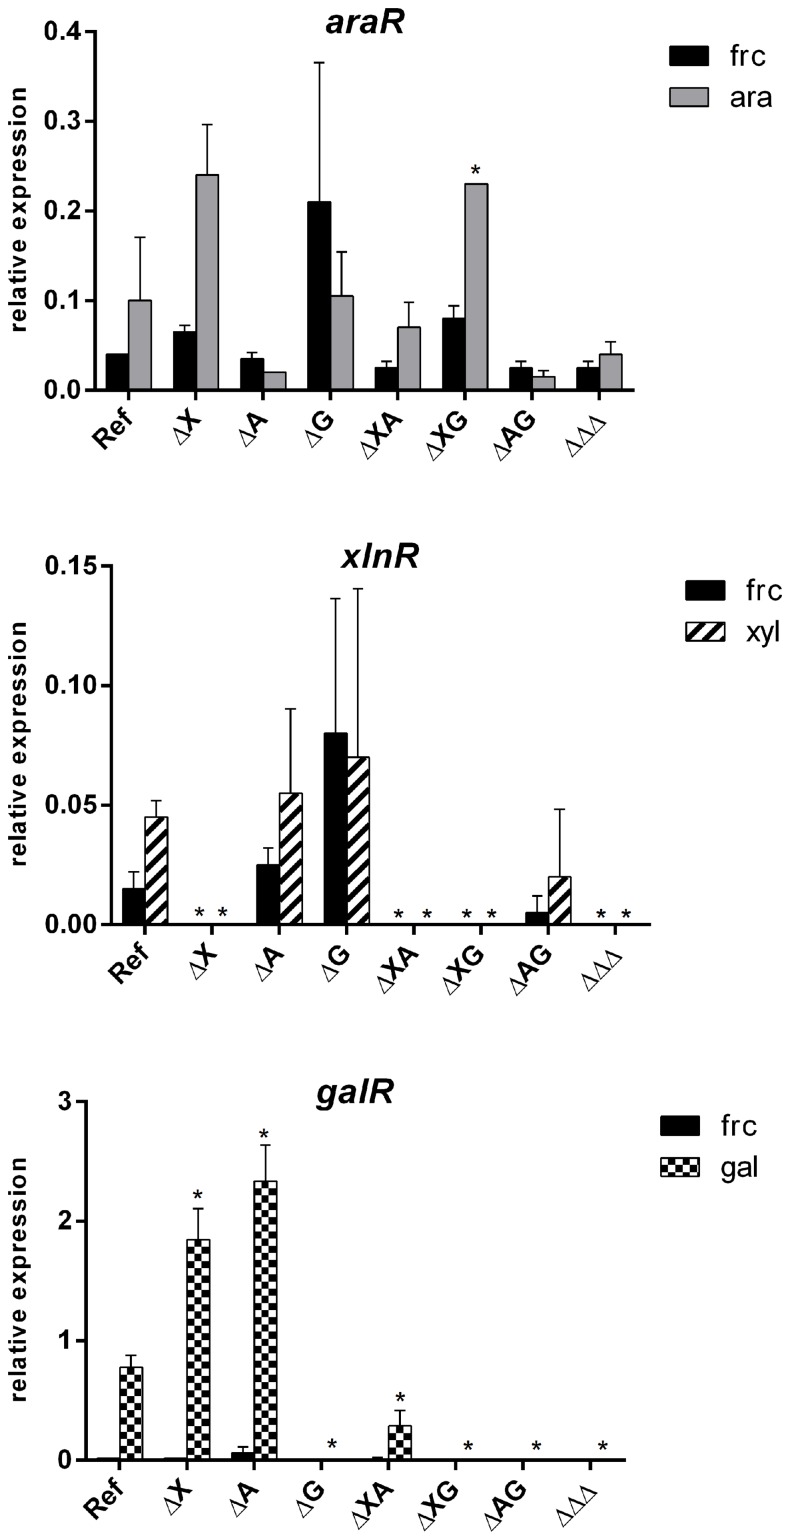
Expression levels of araR, xlnR and galR genes in ΔAraR, ΔXlnR and ΔGalR mutants in A. nidulans.The expression was measured in the reference and single, double and triple regulatory mutant strains of A. nidulans after 2h of growth on D-fructose (black bars), L-arabinose (grey bars), D-xylose (striped bars) and D-galactose (checkered bars). The columns represent the mean and error bars represent standard deviation between biological replicates. Significant change in expression between the reference strain and the mutant was marked by the asterisk.